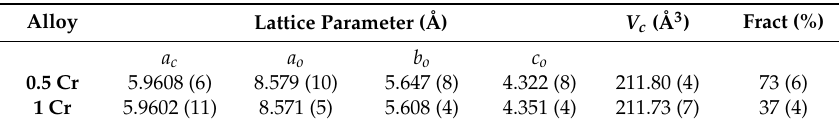
Table 2. Lattice parameters for the austenite ( a c ) and martensite ( a o , b o , c o ) phases, unit cell volume of the austenite phase ( V c ) and the relative volume fraction (Fract%) of the austenite phase in the 0.5 Cr and 1 Cr alloys.